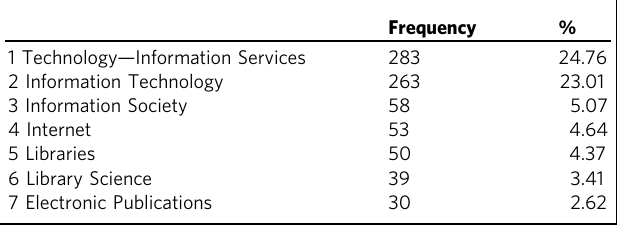
Table 2 Core subject terms in ICT research, 1998 – 2002 ( N = 1143).